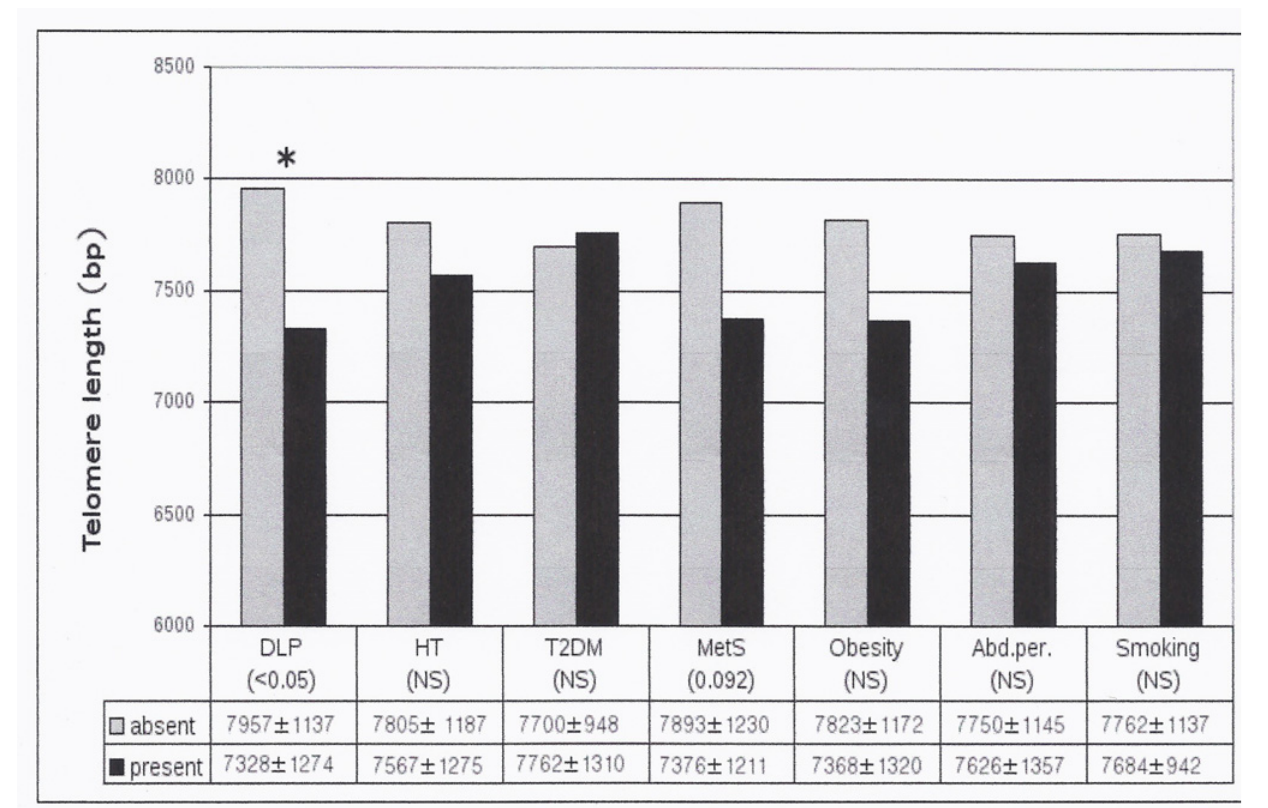
Fig 2. Mean telomere length according to different cardiovascular risk factors after adjustment for age in Cushing's syndrome patients. Abbreviations: bp, base pairs; DLP dyslipidemia, HT hypertension, T2DM Type 2 diabetes mellitus; MetS, metabolic syndrome; abd.per., increased abdominal perimeter. * p <